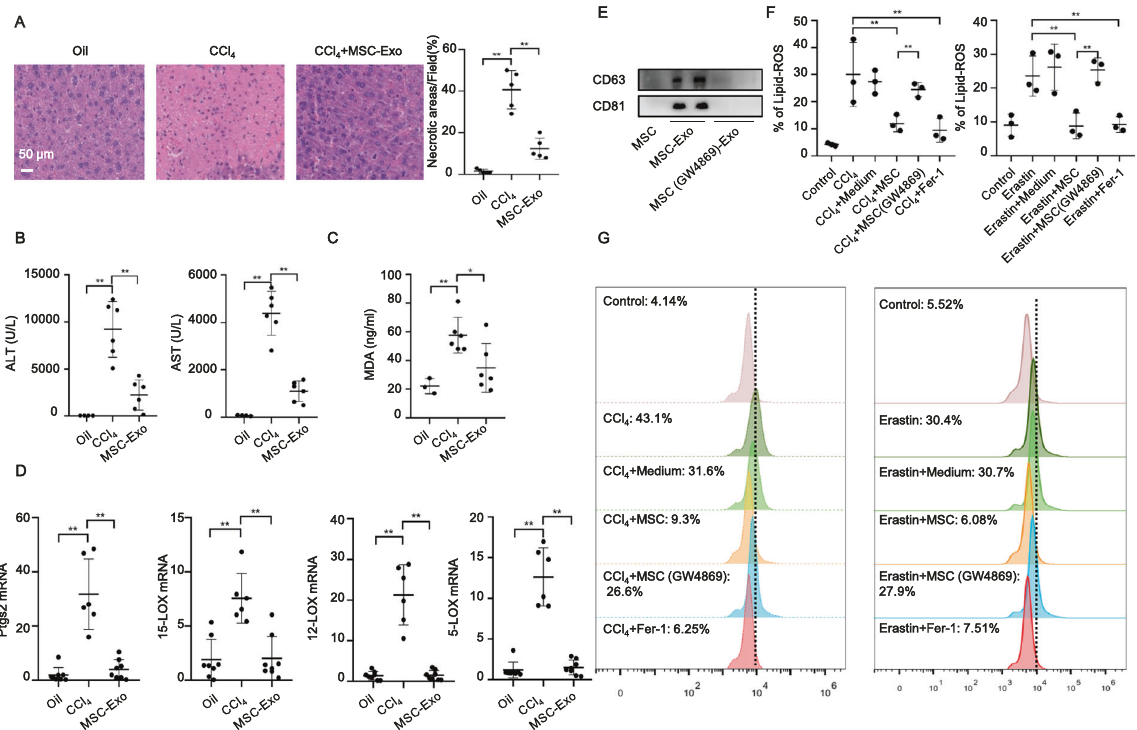
Fig. 5 MSC-Exo mediated the effect of MSCs against CCl 4 -induced ferroptosis in vivo. A HE staining showed that MSC-Exo treatment alleviated CCl 4 -induced ALI. B MSC-Exo dramatically reversed the increased serum levels of ALT and AST induced by CCl 4 . C UPLC-MS/MS detection indicated signi fi cant upregulation of the serum MDA level induced by CCl 4 , which was downregulated following MSC-Exo treatment. D MSC-Exo treatment signi fi cantly reversed the increased mRNA levels of Ptgs2 , 15-LOX , 12-LOX , and 5-LOX induced by CCl 4 in the liver. E WB analysis of CD63 and CD81 in exosomes extracted from MSC-conditioned medium and GW4869 pretreated MSC-conditioned medium. F Lipid peroxidation was measured using C11-BODIPY 581/591 staining in L-02 cells treated with CCl 4 , CCl 4 + Medium, CCl 4 + MSC, CCl 4 + MSC (pretreated with GW4869), and CCl 4 + Fer-1 (left panel). After replacing CCl 4 with erastin, the above experiment was repeated three times (right panel). G Representative histograms of C11-BODIPY 581/591 staining. Signi fi cance was calculated by one-way ANOVA